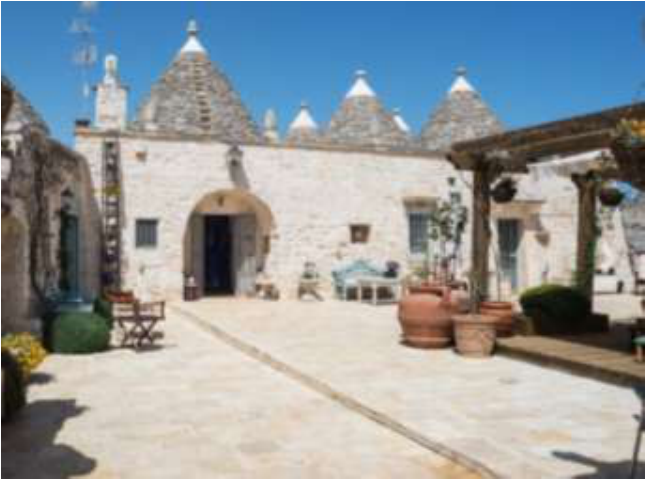
Figure 6. Group of trulli around an inner courtyard.